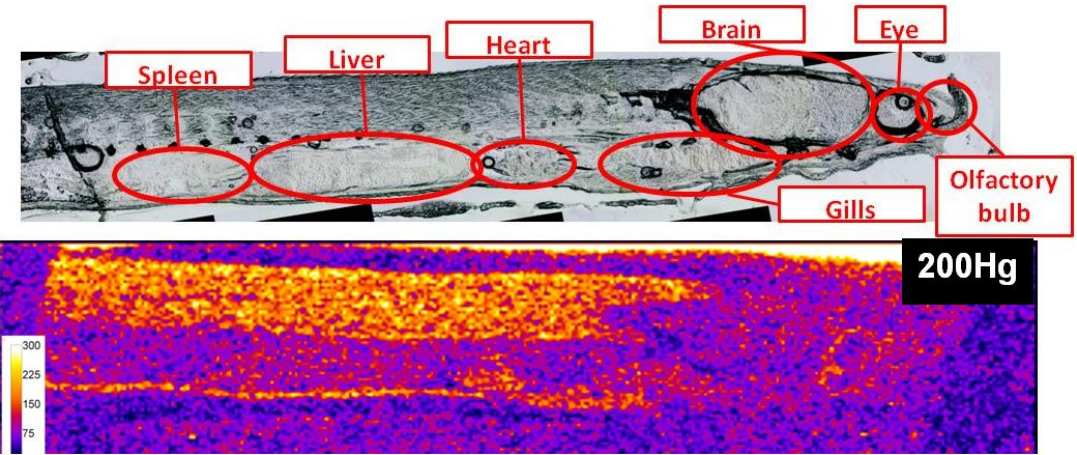
Figure 1. Qualitative distribution of endogeneous 200 Hg in a 50 µm thick section of a glass eel specimen (scale represents 200 Hg signal intensity in counts per second).